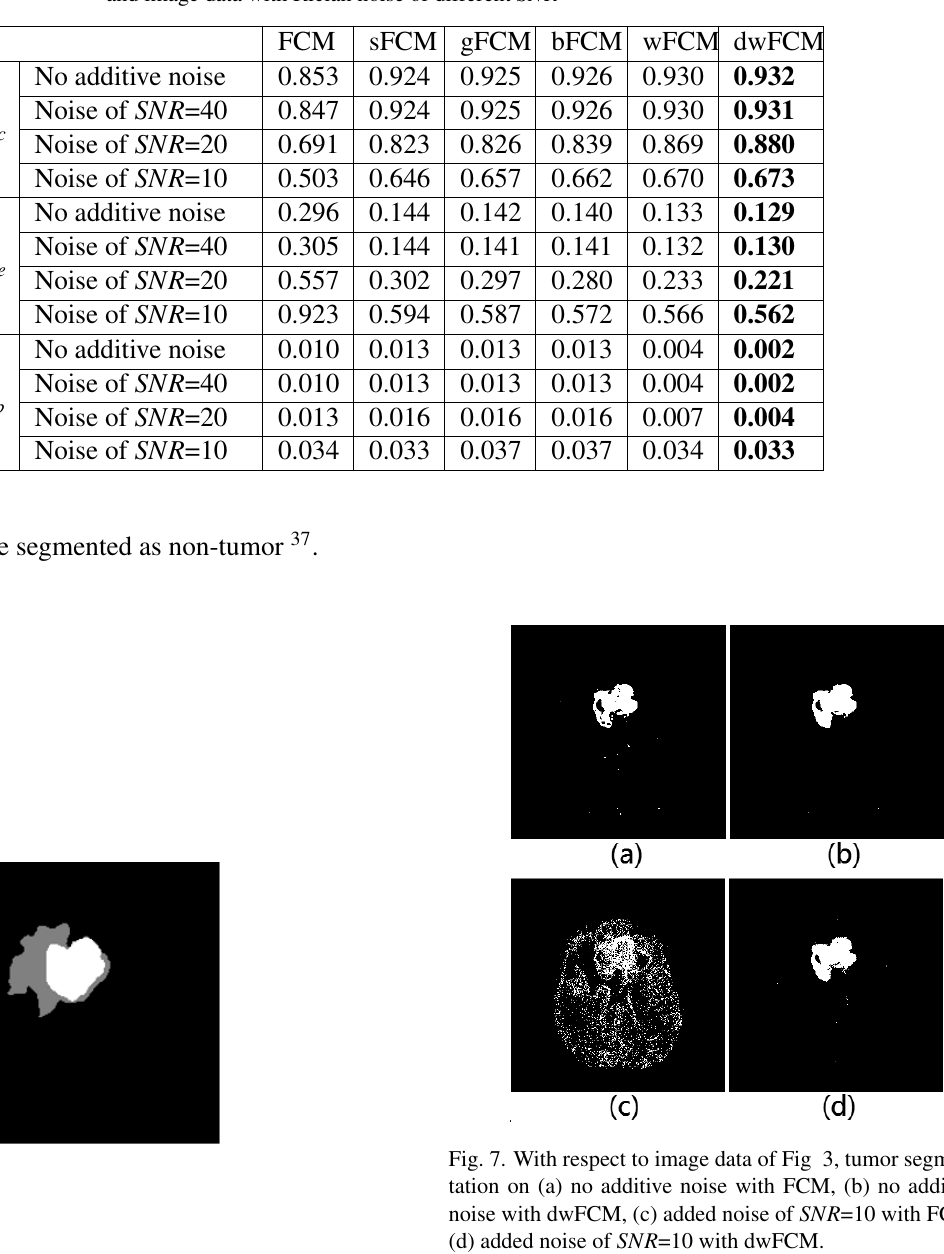
Table 1. Validity function values from various FCM variants and image data with Rician noise of different SNR